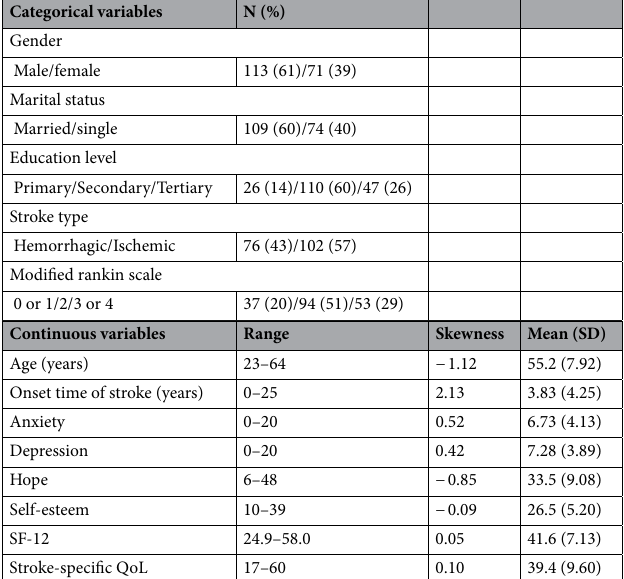
Table 1. Demographic, clinical, and psychological profiles of the study sample at baseline. N = 184; SF-12 = 12-item Short Form Health Survey; QoL = quality of